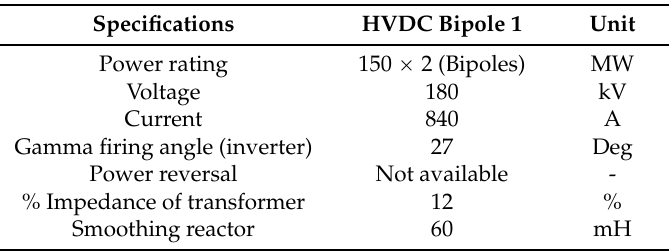
Table 2. HVDC in Jeju Island operation.